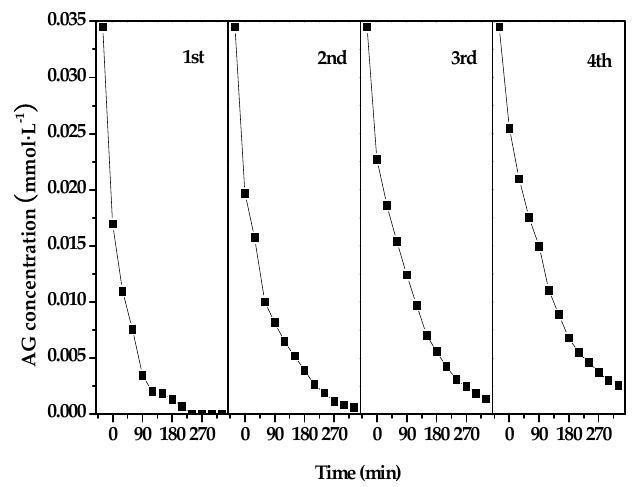
Figure 16. Repeated photocatalytic degradation tests of AG with 10% PANI-modified BiYTi 2 O 7 .